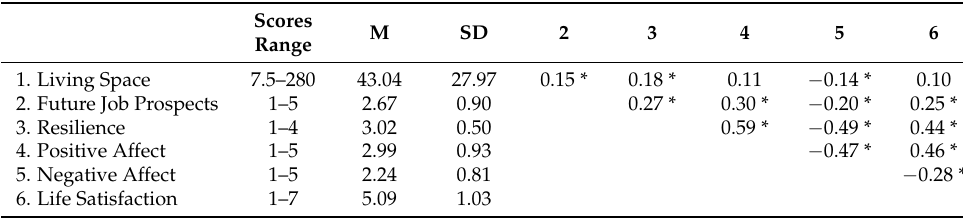
Table 2. Means (M), standard deviations (SD), and Pearson correlation coefficients among the variables in the study ( n =